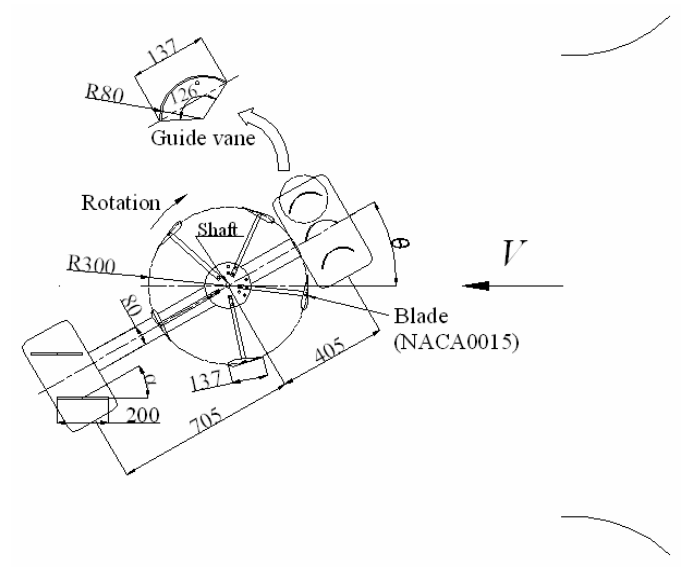
Fig. 1 Straight-bladed vertical axis wind turbine with directed guide vane row